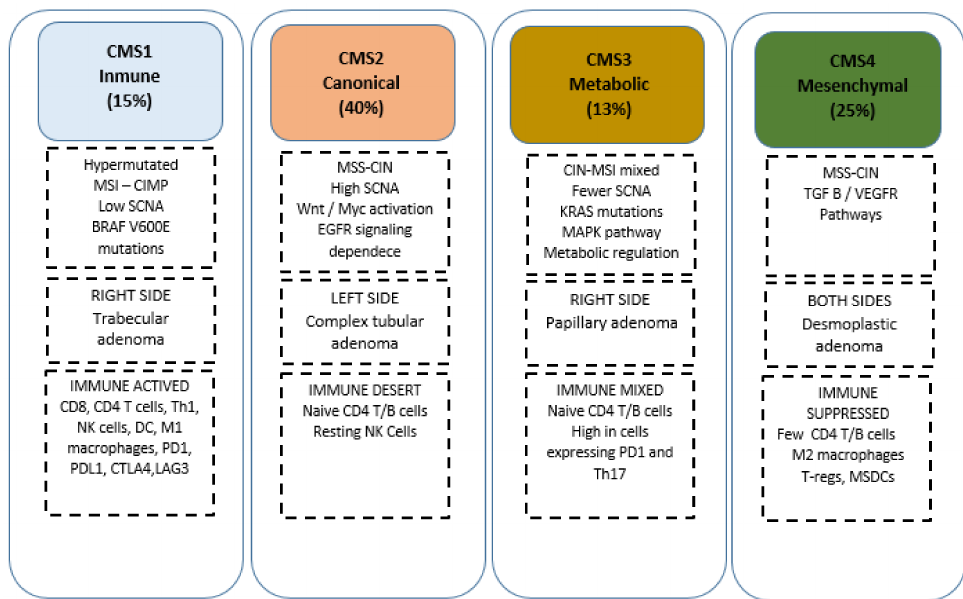
Figure 1. CMS classification. CIN, chromosomal instability; CMS, consensus molecular subtypes; DC, dendritic cell; EGFR, epidermal growth factor receptor; MSDC, myeloid-derived suppressor cells; MSI, microsatellite instability; MSS, microsatellite stability; NK, natural killer; PD-1, programmed cell death protein 1; TGF- β , transforming growth factor beta; Tregs, regulatory T cells; LAG3, lymphocyte activating 3; Th17, lymphocyte T helper